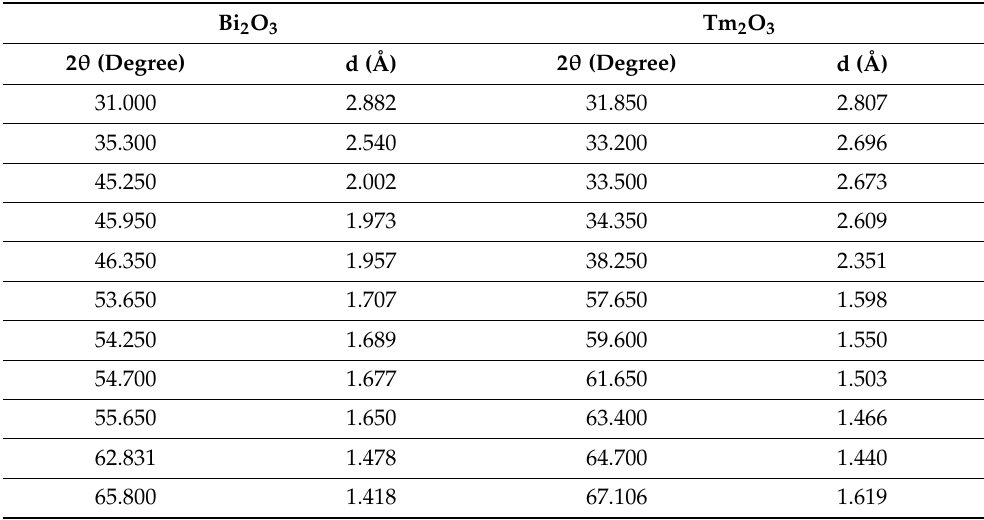
Table 1. The most intense XRD pattern reflections characteristic of the Bi 2 O 3 and Tm 2 O 3 content in the Bi 2 O 3 /Tm 2 O 3 (28